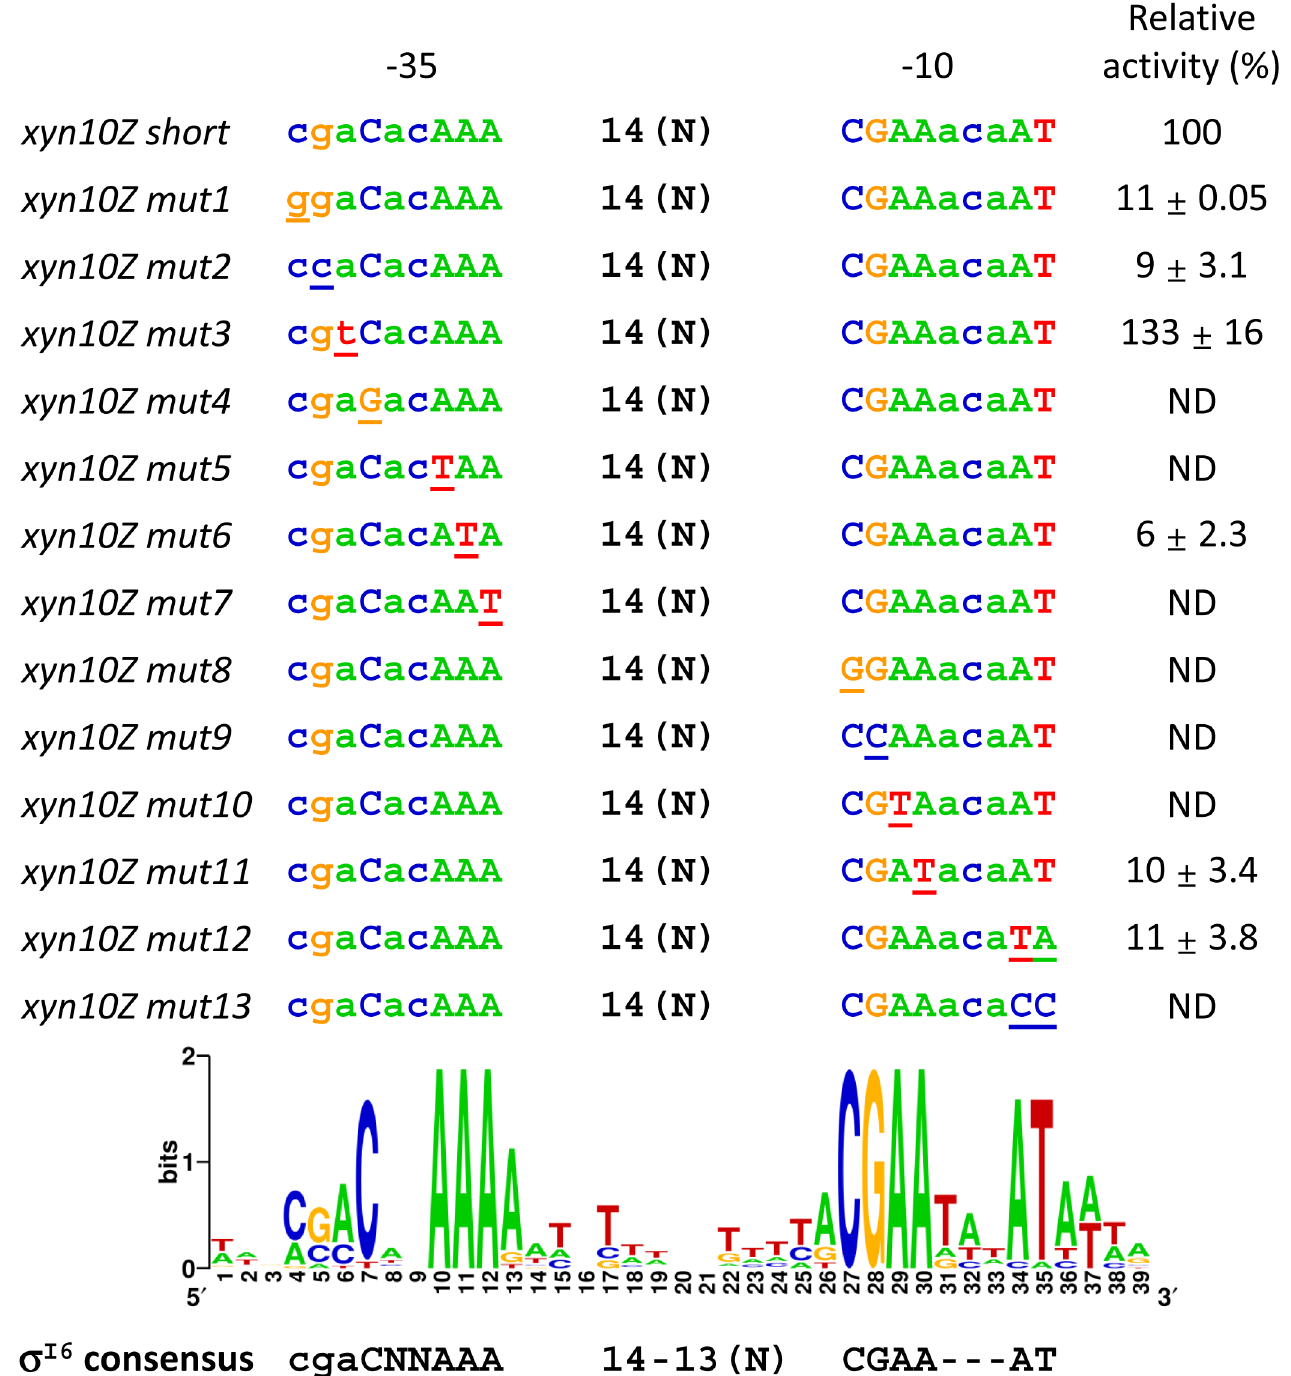
Fig 3. Evaluation of σ I6 promoter sequence validity by mutagenesis. The activities are shown as relative activities, with the control promoter xyn10Zshort without mutations set to 100%. ND means not detected.